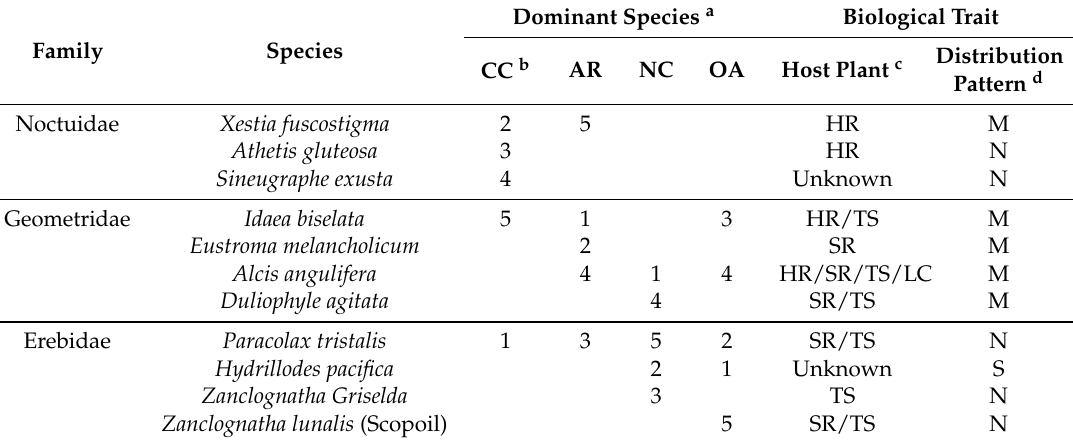
Table 3. Biological trait of dominant moth species in four different treatment stands.